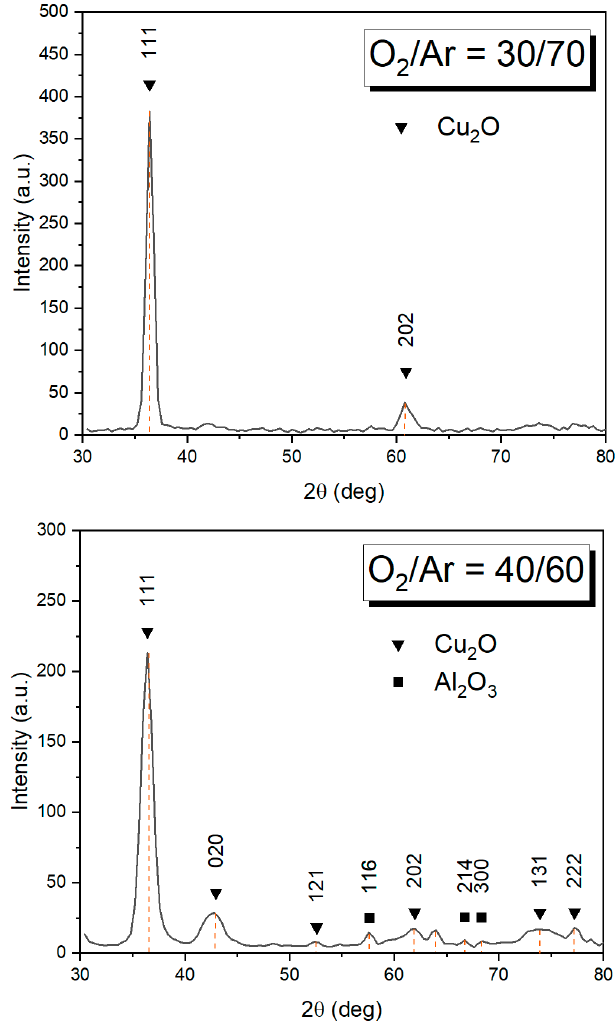
Figure 10. XRD diffractograms of copper oxide sublayer films.